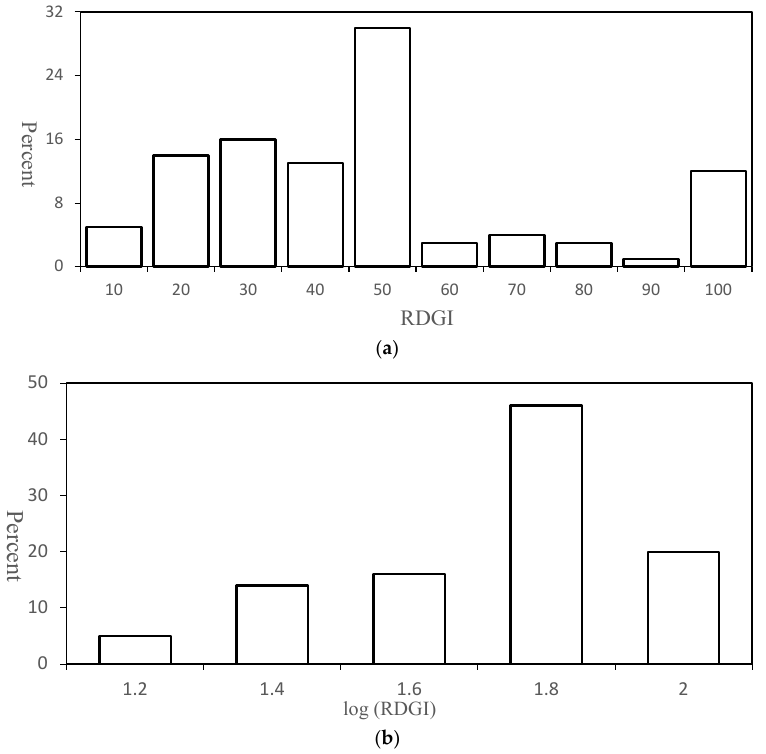
Figure 2. Distribution of reduction degree of grazing intensity at the original scale and logarithm transformed scale (for positive percentage). ( a ) Reduction degree in original scale (in percent); ( b ) Reduction degree in logarithm transformed scale.